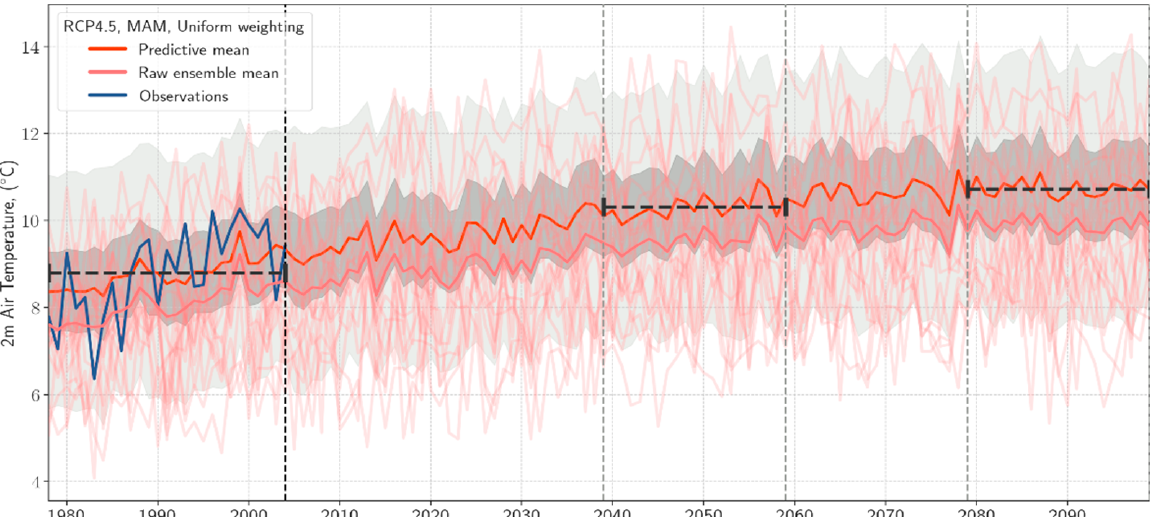
Figure 7. Baseline window and two predictive windows for the prost-processed CMIP5 RCP 4.5 temperature projections, river Po basin, Northern Italy. Seasonal mean observed temperature (blue), unprocessed ensemble output (pink), ensemble mean (light red) and post-processed predictive mean (flash red), spring (MAM). The grey-shaded areas indicate the 50% and 95% credible intervals (redrawn from [4]).